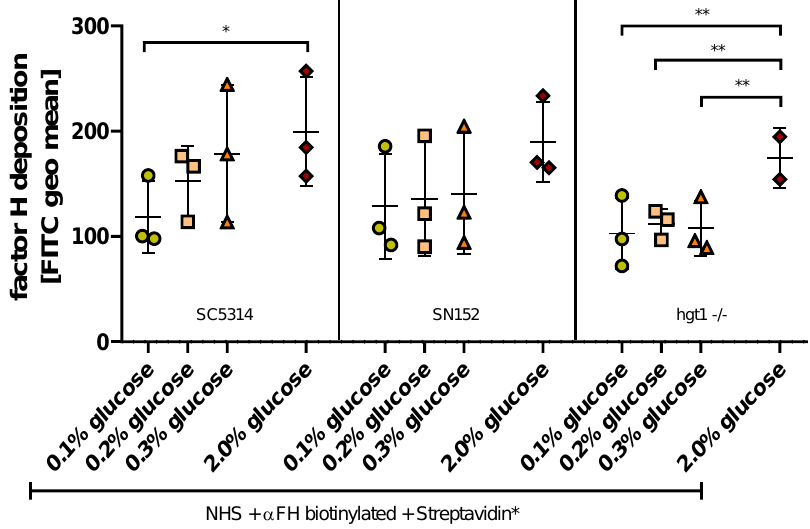
Figure 4. Factor H (FH) deposition on the surface of Candida albicans yeast cells incubated overnight at different glucose concentrations. Yeast cells of wild type (SC5314), parental (SN152), and HGT1 knockout (hgt1-/-) strains were incubated in yeast peptone medium with either 0.1%, 0.2%, 0.3%, or 2% glucose and opsonized with 40% normal human serum (NHS). A specific anti-FH antibody (αFH) was used and the deposition was measured using fluorescence-activated cell sampler (FACS) Verse with BD software. The deposition of FH is shown in fluorescein isothiocyanate (FITC) geometric mean (geo mean). The results shown were gained by three independently performed experiments (mean ± SD). Stars (*) indicate the level of significance for an adjusted p -value, comparing pairs of groups using a Tukey post-hoc analysis after the one-way ANOVA reported significance.